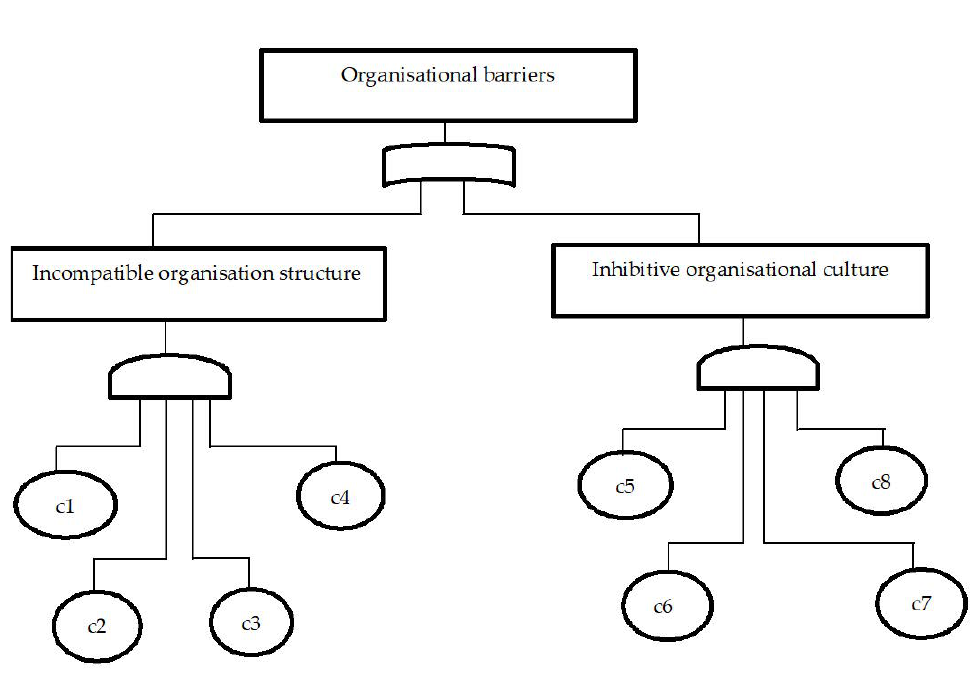
Figure 4. Independent fault tree analaysis for probable causes due to organisational barriers (O). Table 7. Assigned codes and description for basic events under organisational